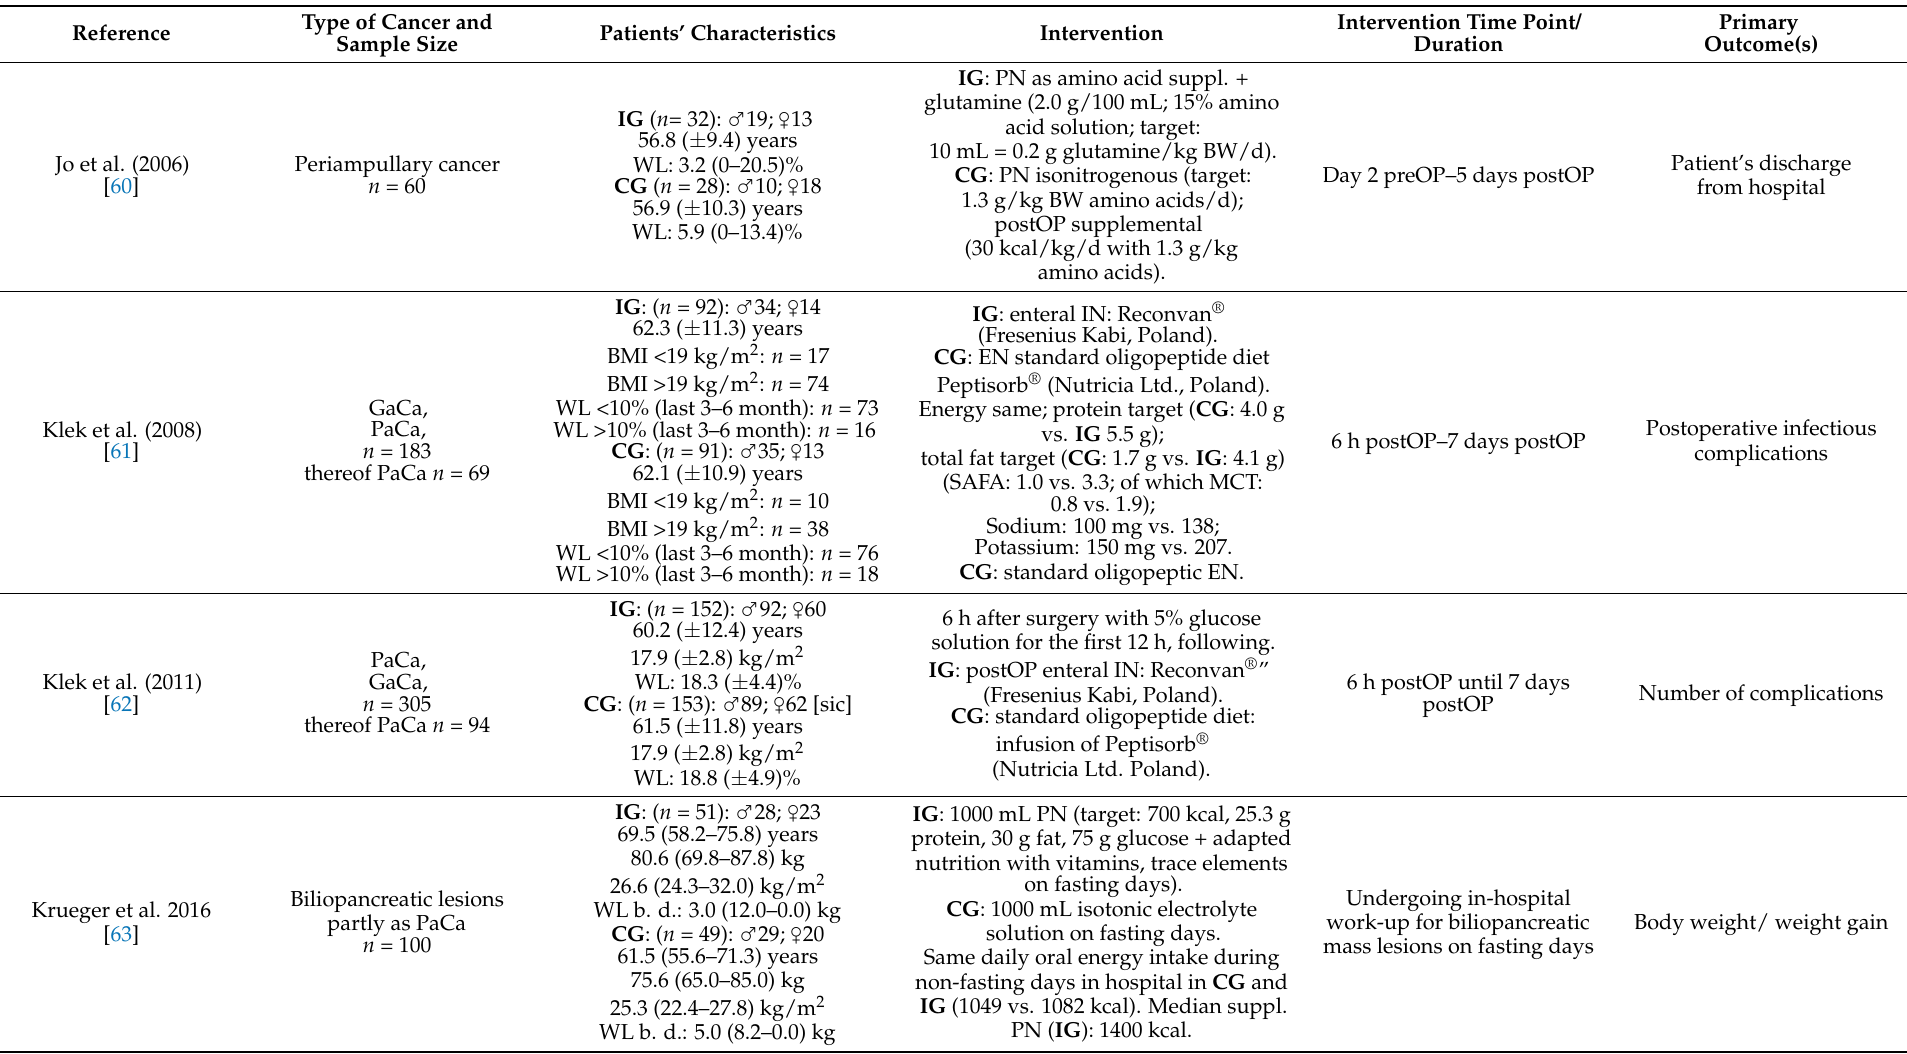
nutrition with vitamins, trace elements on fasting days). CG : 1000 mL isotonic electrolyte solution on fasting